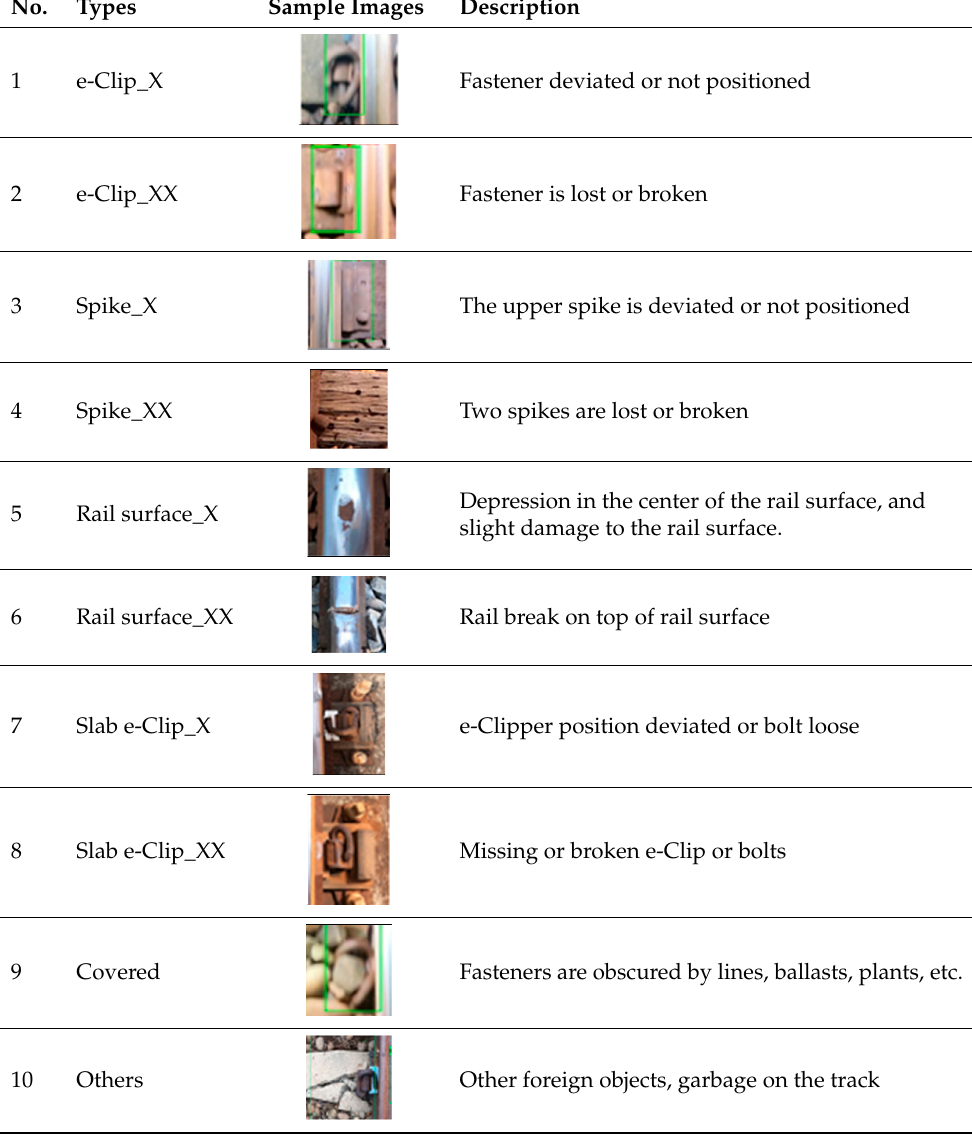
Figure 4. Two samples of light loose (X) track fasteners.